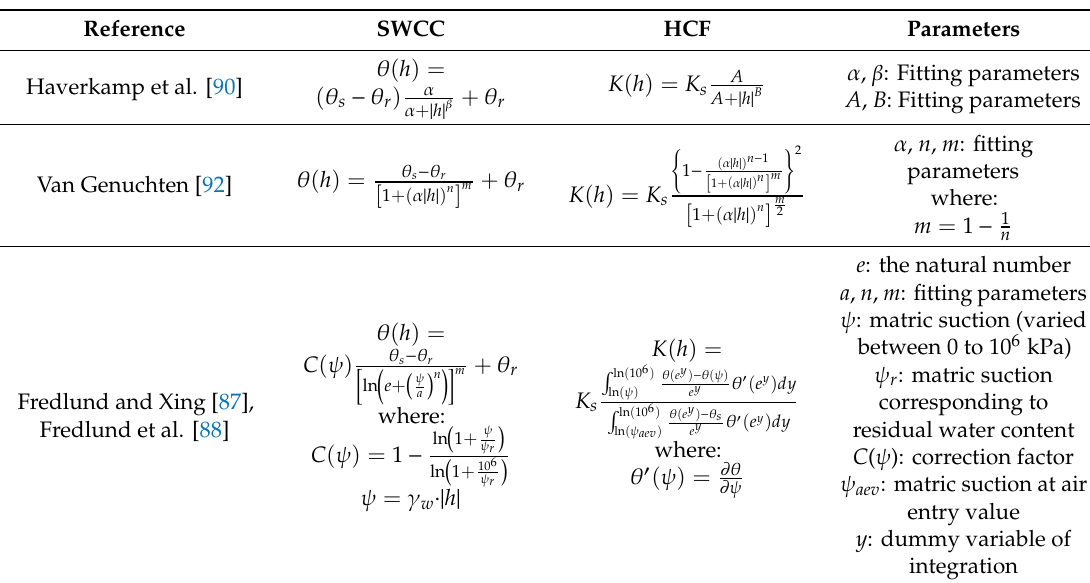
Table 4. The available soil-water characteristic curve (SWCC) and hydraulic conductivity function (HCF) relationships in the integrated two-dimensional slope stability model